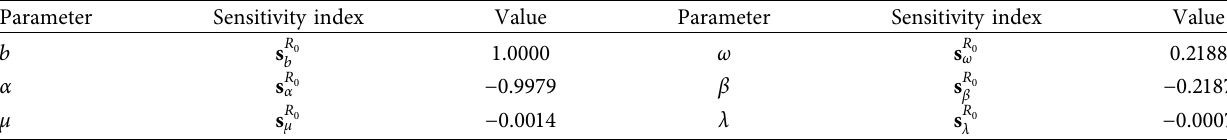
versus proposed 0